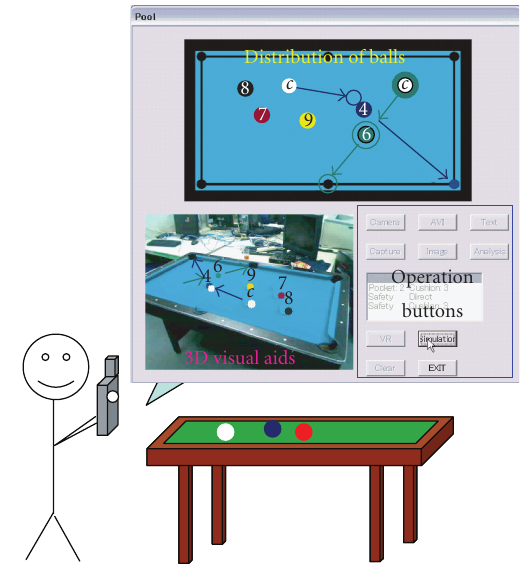
Figure 1: System